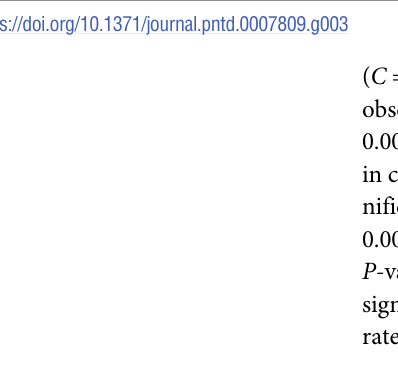
Table 2. The global T -seroprevalence and number of seropositive people in the general population in the WHO regions. WHO-region(s) Seroprevalence estimates (%) Population size per region � Number of seropositive people (range) [95% CI] Global (all 6 WHO